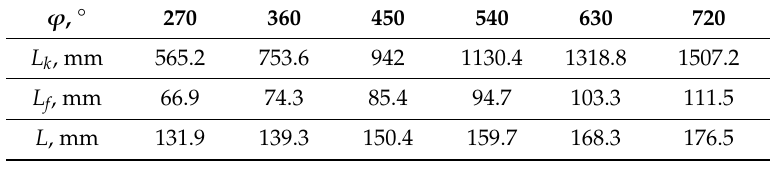
Table 1. Effect of the rotation angle ϕ in the forming zone on the tool length (according to Figure 8) in the numerical analysis.